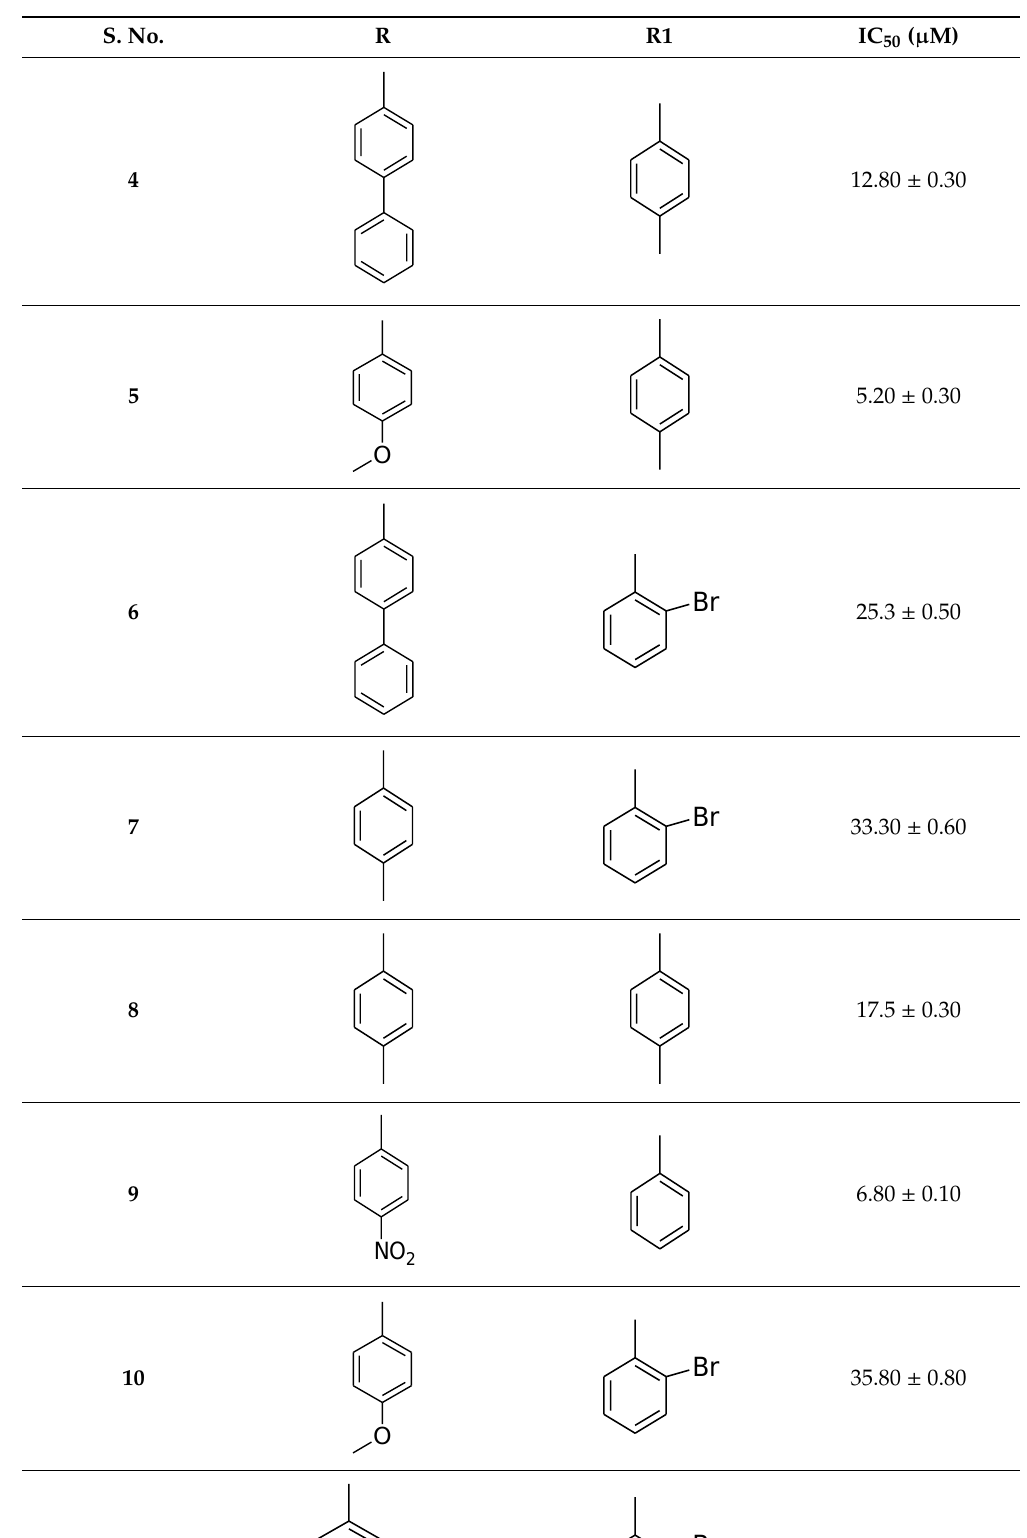
Table 1. Cont. Table 1. Structure of triazinoindole-based thiosemicarbazide analogs and their α-glucosidase activity. S. No. S. No.